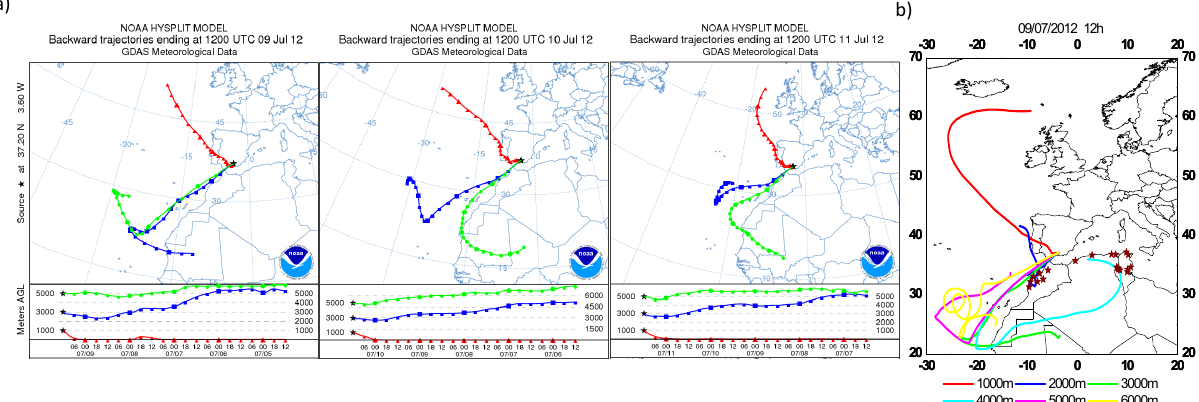
Figure 6. (a) Five-day backward trajectories arriving over Granada on 9, 10, and 11 July 2012 at 12:00UTC (from left to right) computed by the HYSPLIT model. (b) Locations of the main industrial activity in the north of Africa (brown stars) taken from Rodríguez et al. (2011) together with the 5-day backward trajectories arriving at the Granada experimental site on 9 July 2012 at 12:00UTC.